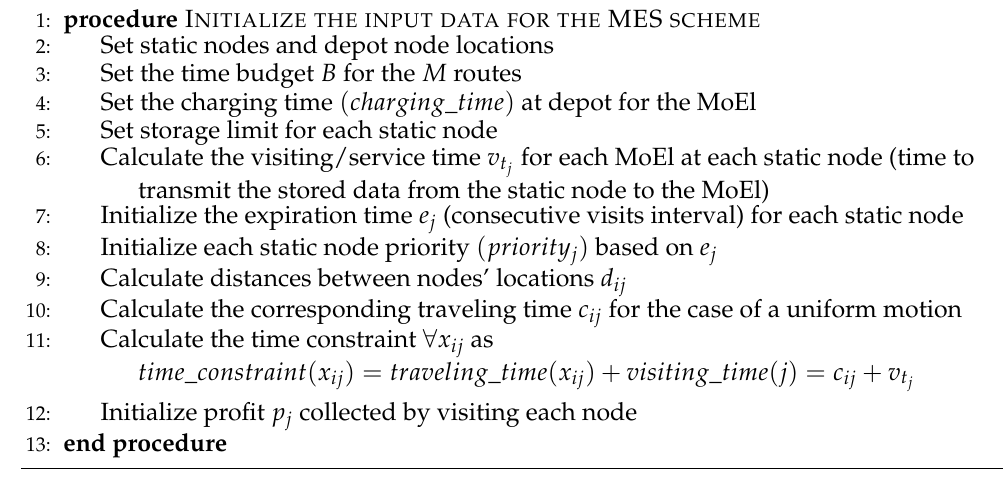
Algorithm 1 Initialization phase of Mobile Element Scheduling scheme